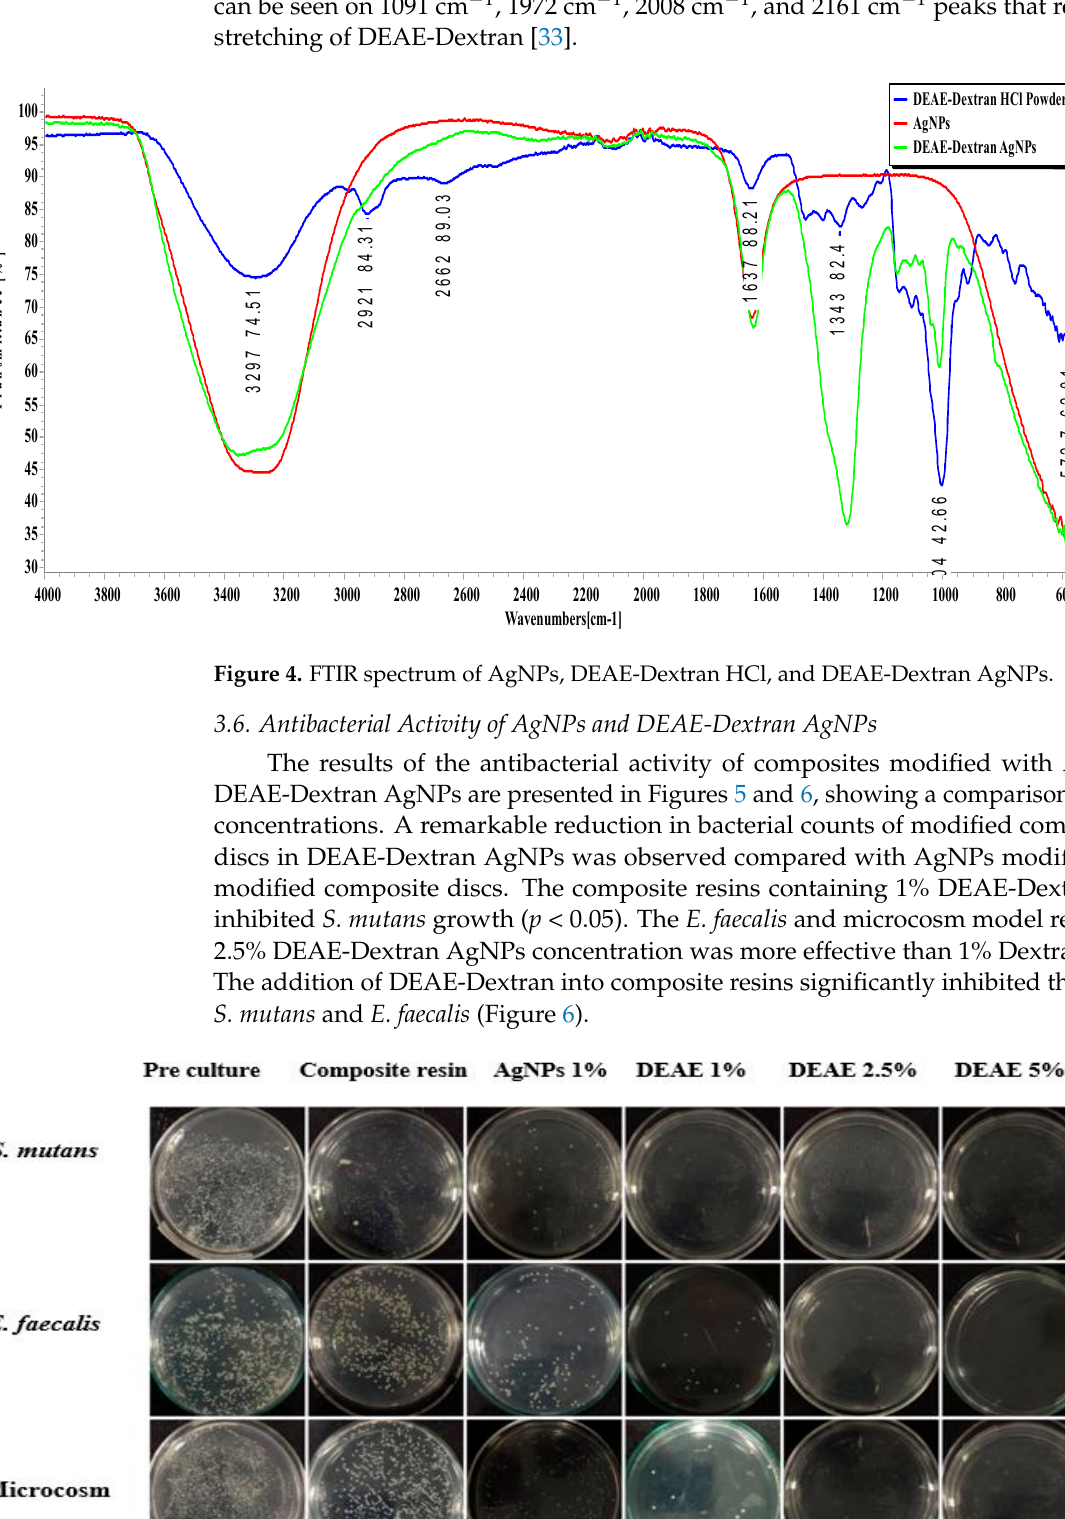
Figure 5. Bacterial colonies on TSA plates.